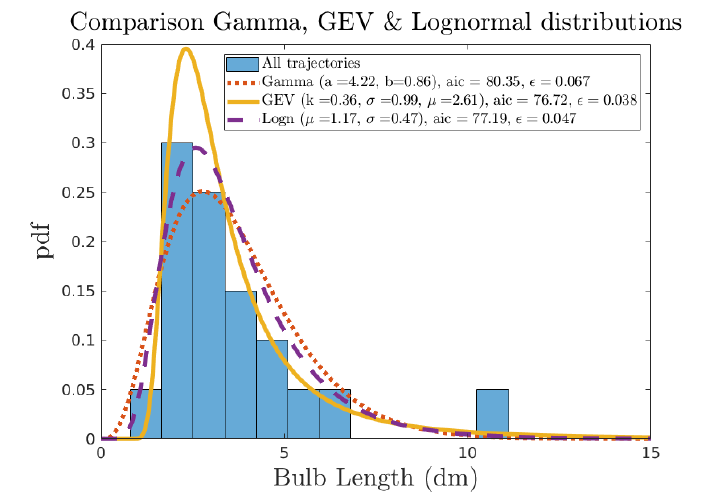
Figure 11. Comparison of three distributions to fit the experimental distribution of bulb